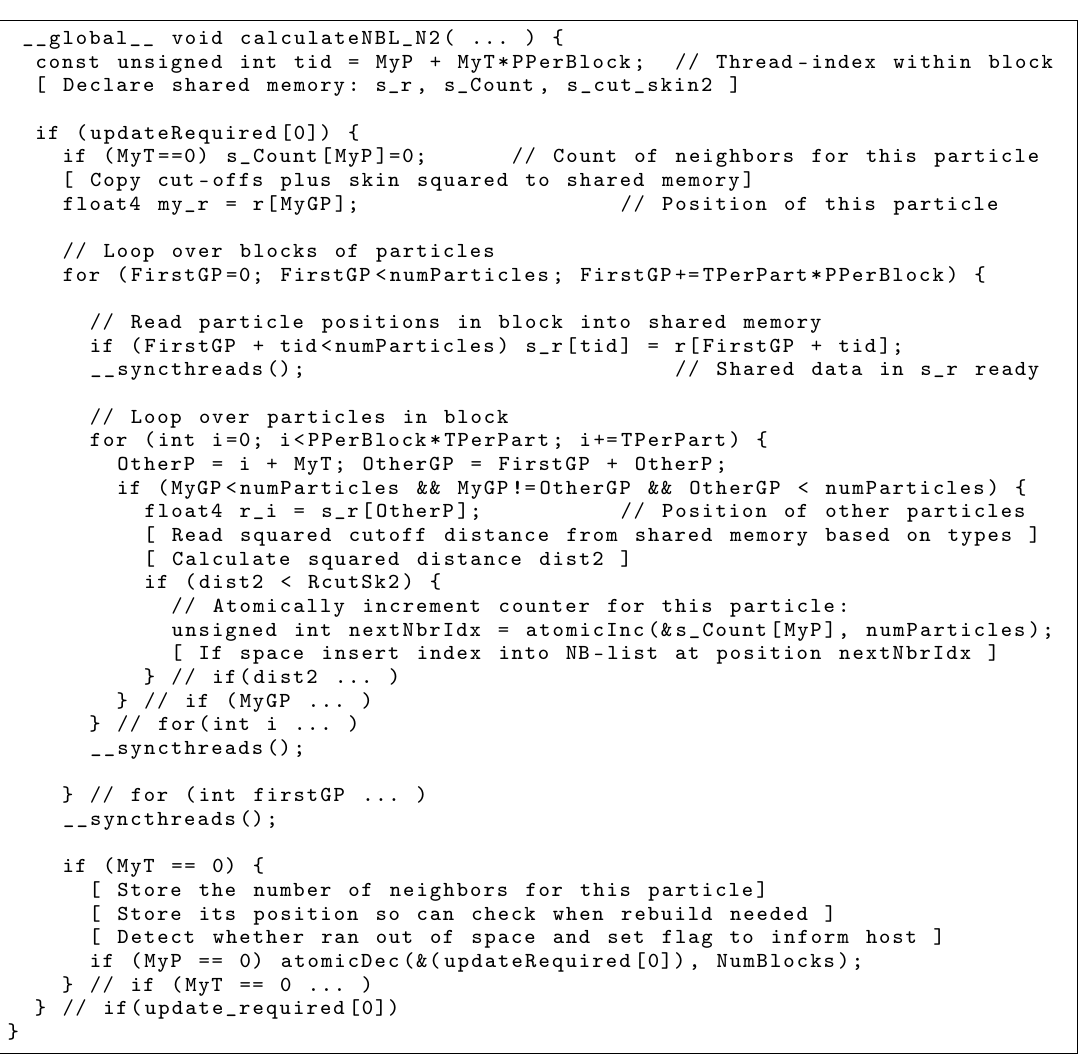
Figure 4: Kernel for order-N 2 neighbor-list generation. Note that because the number of par- ticles is not in general a multiple of p , there are some threads in the last block which should b not do anything, hence statements such as if(MyGP<numParticles)